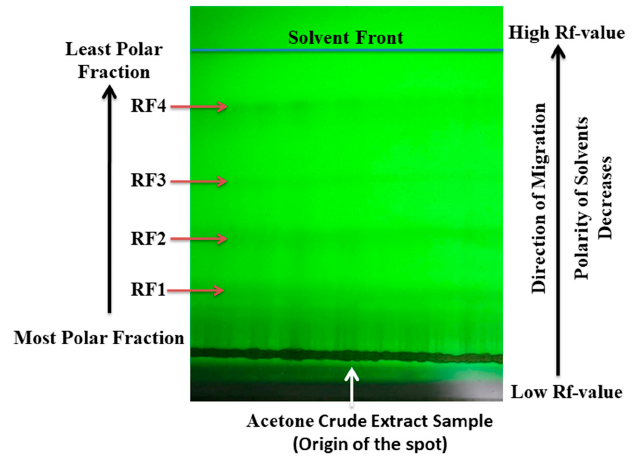
Figure 10. TLC-UV fractionation of crude S. triloba acetone extract. Four fractions were generated from the acetone extract by thin layer chromatography (TLC); the calculated retention factors (Rf) ranging from 0.2 to 0.8 suggested a mixture of compounds with varying polarities whose bioactivities require further investigation. Table 8. Retention factors of S. triloba acetone extract fractionations.